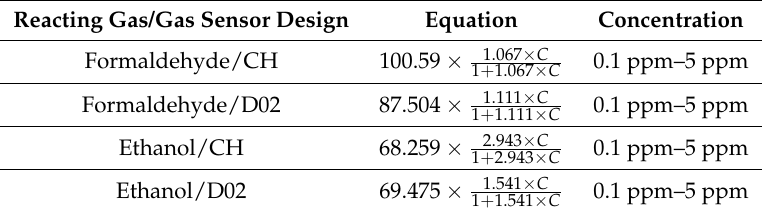
Figure 7. Sensing characteristics of the composite heater (CH) and the D02 design operating at 10.5 mW. ( a ) The gas sensor response towards formaldehyde and ethanol gases at concentrations in the ppb and ppm range. The curves in ( a ) represent the equations depicted in Table 1 to fit the data. ( b ) Baseline response of the two sensors during operation for 25 min. Table 1. Summary of the sensing characteristics of both designs, shown in Figure 7a. The equation column calculated using the Langmuir isotherm model shows the best-fit lines for the sensitivity of the gas sensors (solid lines in Figure